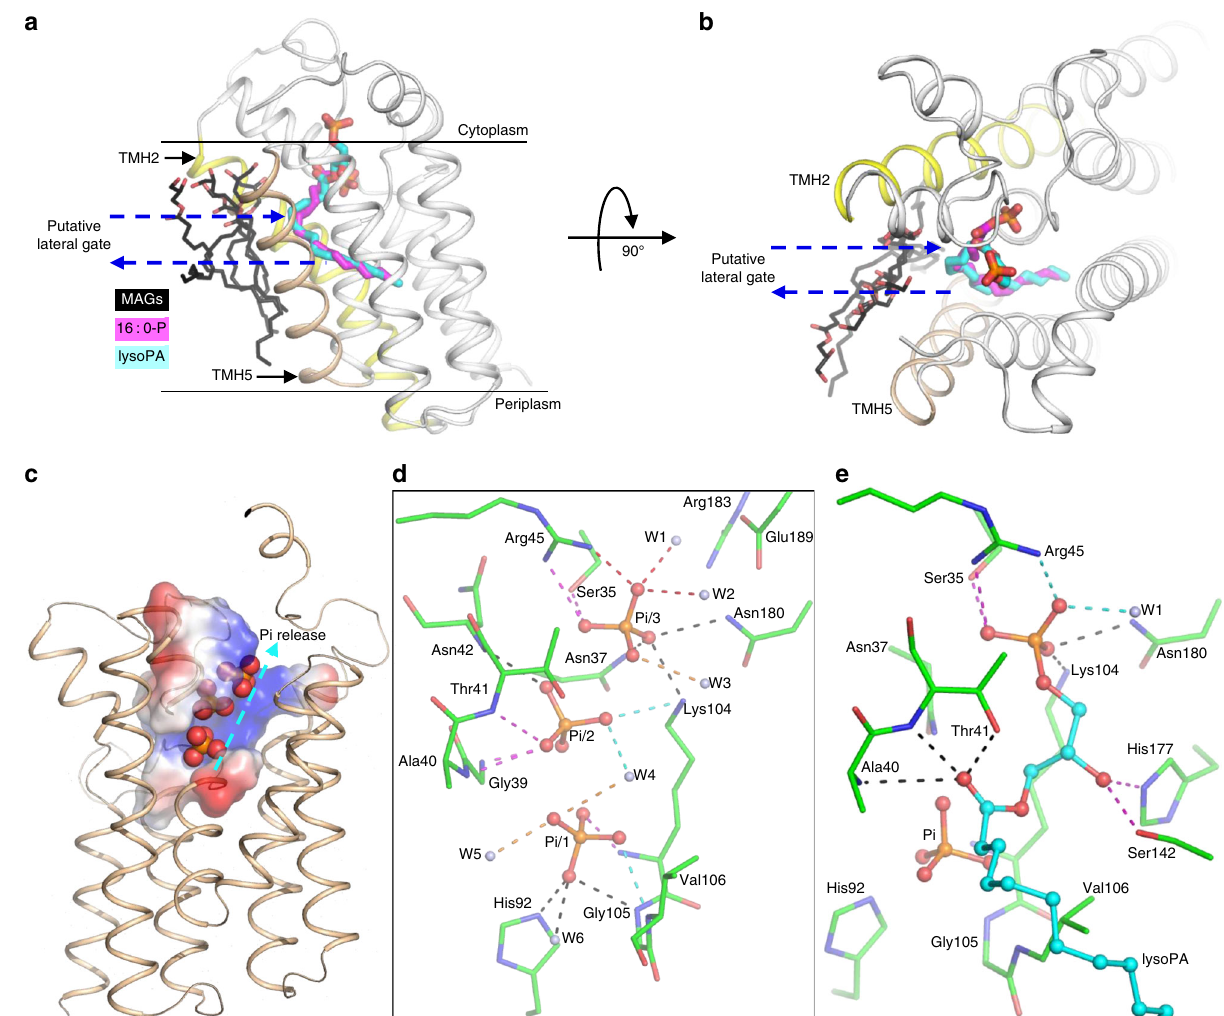
Fig. 5 Structure insights into substrate access, product egress, and product inhibition. a , b The putative lateral gate for acylP access and lysoPA egress. a View from the membrane; b view from the cytoplasm. The carbon atoms of MAGs, 16 : 0-P and lysoPA are colored black, magenta, and cyan, respectively. The gate-forming TMH2 and TMH5 are colored yellow and wheat, respectively. c Overview of the aa PlsY structure with Pi bound. The region involved in phosphate binding are shown as electrical potential surfaces. Positively and negatively charged surfaces are shown as blue and red, respectively. d Interactions between the three phosphates and aa PlsY. e Interactions between lysoPA and aa PlsY. In d and e , Dashed lines indicate distances within 3.2 Å. When appropriate, the dashed lines are colored differently for better